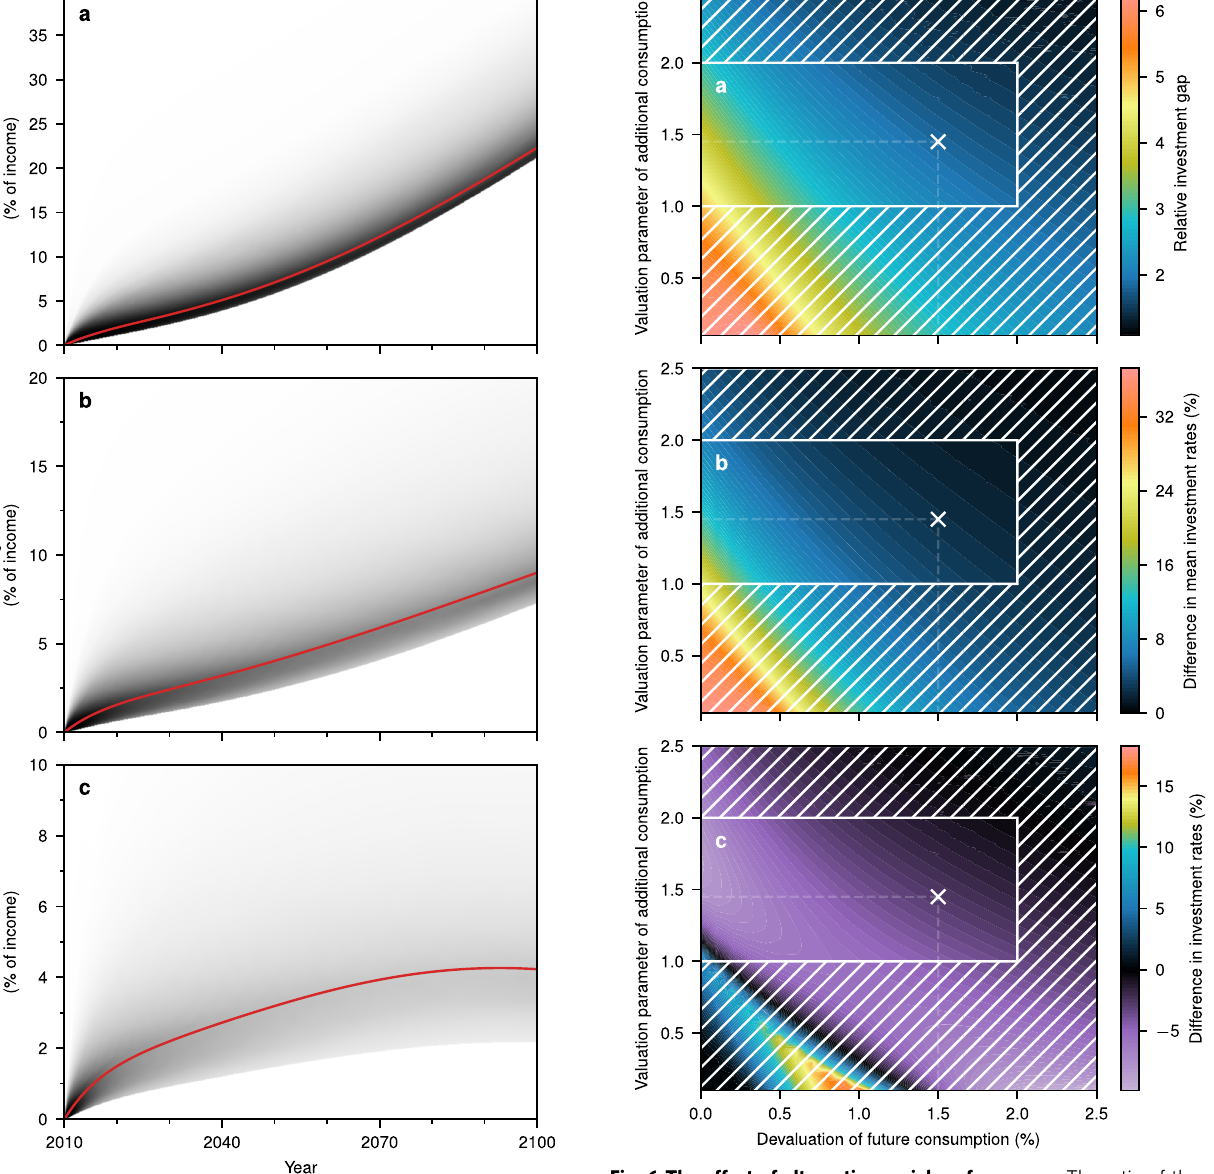
Fig. 6 The effect of alternative social preferences. a The ratio of the investment gaps ð I nocc opt (cid:1) I cc opt Þ ð I nocc in 2100. b Difference between the temporally opt (cid:1) I cc unadj Þ averaged unadjusted and optimal investment rates of the years 2010 – 2100. c Difference in the optimal investment rate between 2100 and 2010. The unhatched area depicts the range as commonly used in the economic literature and the white marker indicates the baseline calibration. Source data are provided as a Source Data fi